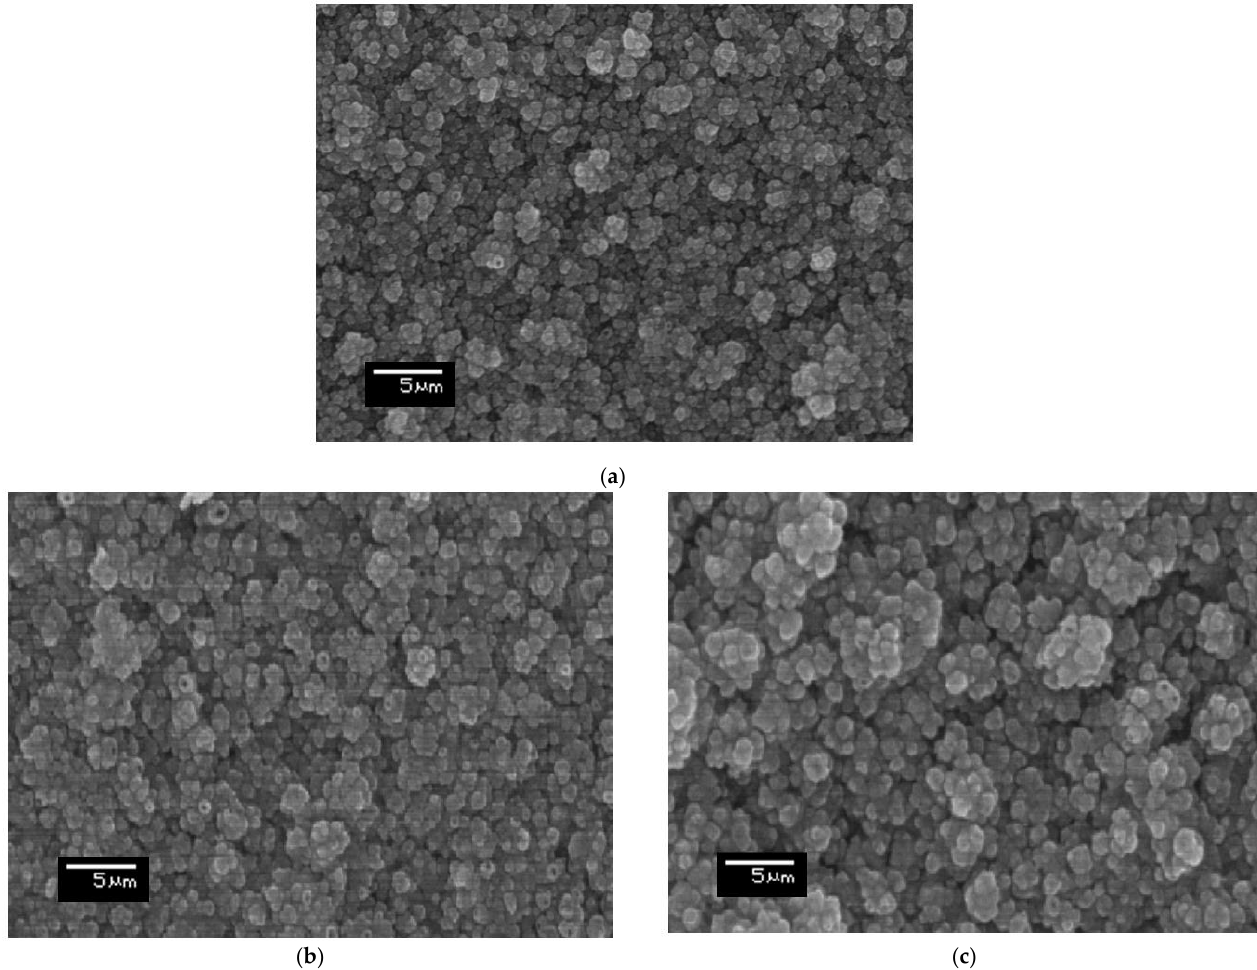
Figure 2. Top-view SEM micrographs of the sputtered CZTSe films that were thermally annealed at ( a ) 300 °C, ( b ) 400 °C, and ( c ) 500 °C.